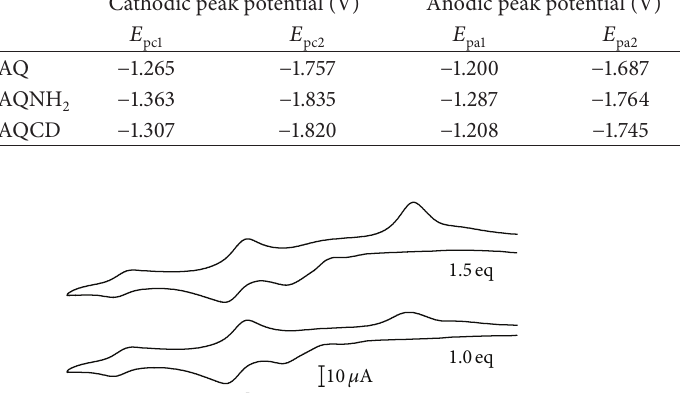
, and AQ in 0.1 M TBAPF 2